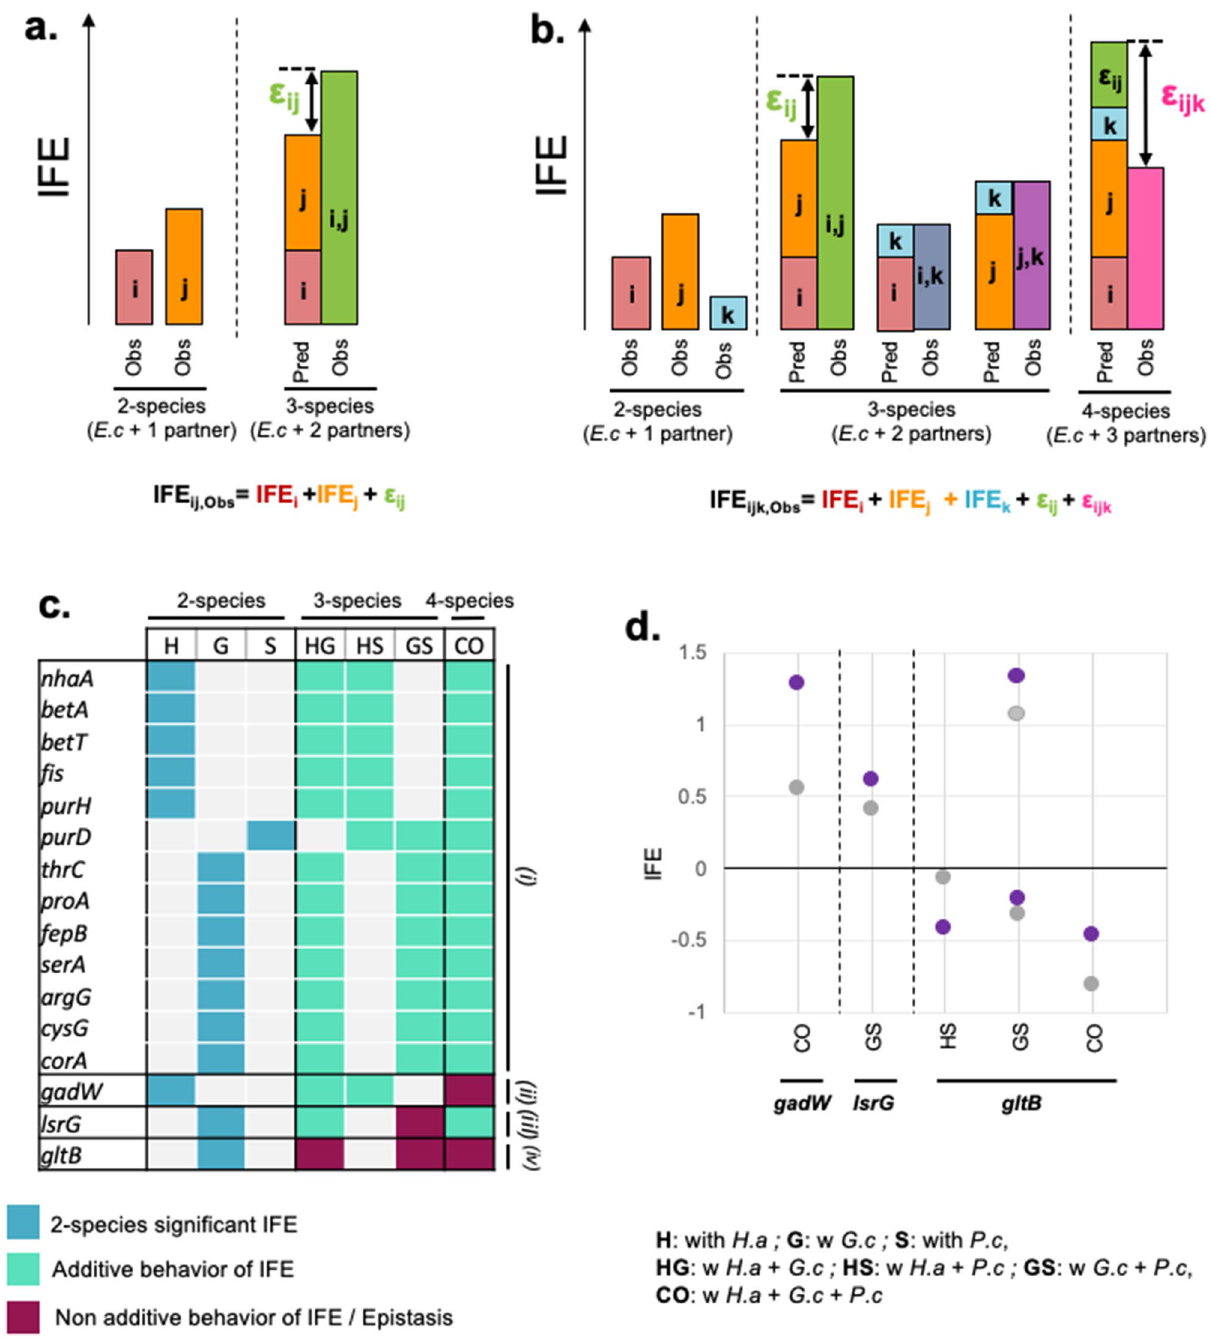
Figure 4. Quantitative analysis of IFE conservation for the interaction-associated mutants conserved from 2-species to 4-species conditions. ( a ) Schematized quantitative epistasis/non-linearity measured in 3-species conditions (with partner i and j). Epistasis (ε ij ) is the difference between the individual IFE of partner i and partner j (red and orange bars) versus placing them together (green). Mathematically, we need three terms (IFE i , IFE j , and ε ij ) to reproduce the observed IFE for the 3-species condition. ( b ) This analysis can be extended to higher levels of community complexity: 4-species ( E. coli with 3-partners i, j, and k). The model first accounts for epistasis between i/j, i/k, and j/k. In this example, i and j exhibit epistasis; i/k and j/k are additive (dark blue and purple). The predicted IFE for the 4-species community is the sum of the individual 2-species effects (red, orange, light blue) and the 3-species epistatic terms (green). The 4-species epistatic coefficient is the difference between this low-order prediction and the observed IFE for the i,j,k community (pink). ( c ) Conservation profiles of the 16 2-species interaction-associated mutants conserved up to 4-species. 2-species conditions: a colored square indicates the 2-species condition(s) in which the interaction-associated mutant was identified; a grey square indicates non-significant 2-species IFEs. 3-species conditions: a teal square indicates that the associated IFE is associated with additive behavior from associated 2-species IFE (no ε ij epistatic coefficient), a red square indicates that the associated IFE displays non-additivity from 2-species IFE and thus epistasis, a grey square corresponds to a 3-species condition that is not associated with significant 2-species IFE (no epistasis analysis performed); 4-species condition: a teal square indicates that the associated IFE is associated with additive behavior (no ε ijk epistatic coefficient) , a red square indicates that the associated IFE is associated with non- additivity from lower-order IFE. ( d ) Comparison of the observed and predicted IFE for the genes and condition associated with 3-species and 4-species non-additive